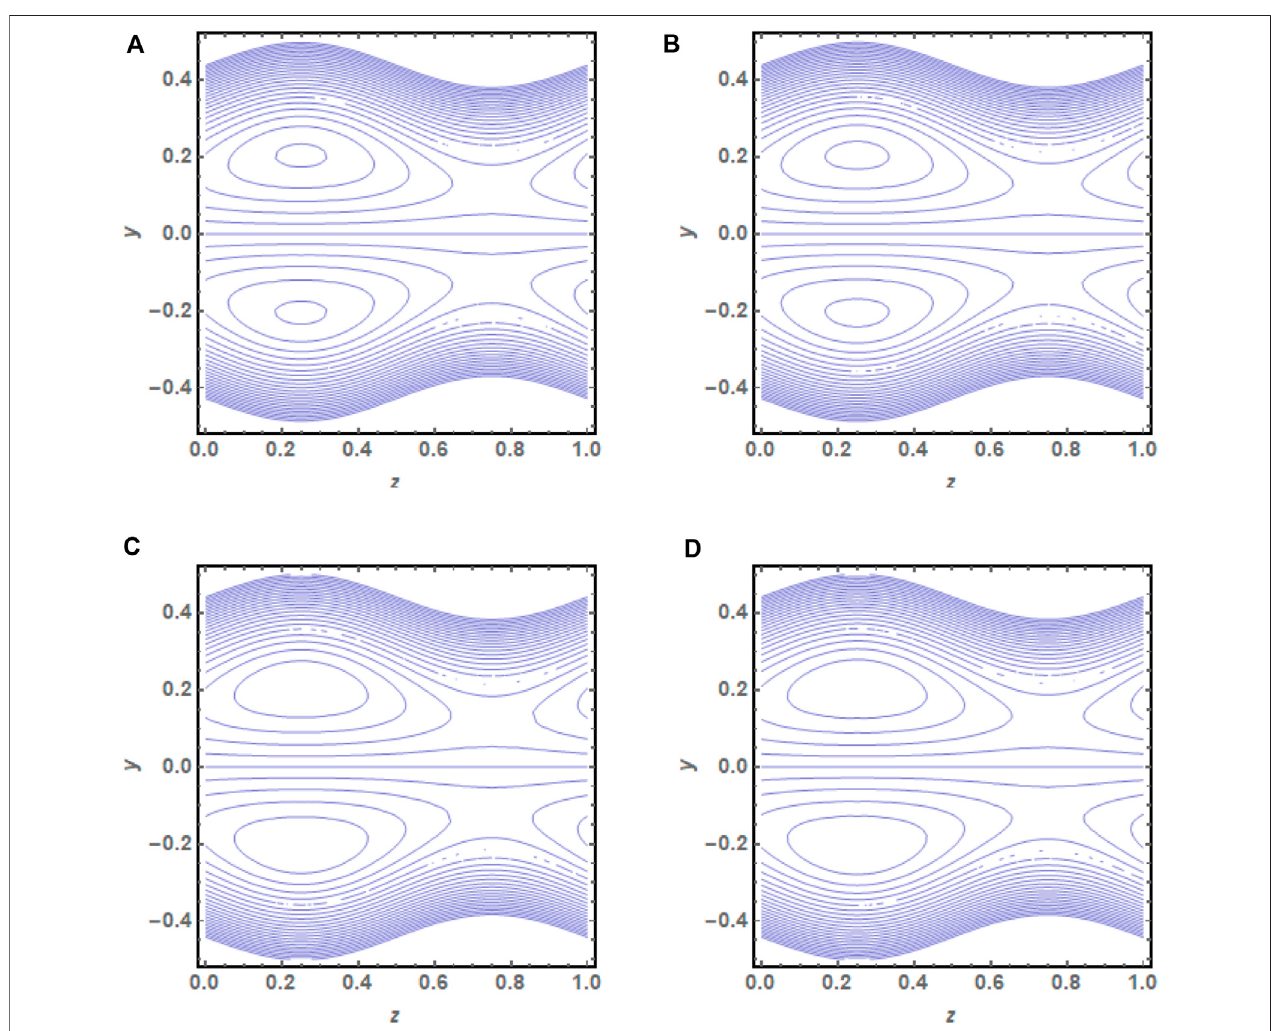
FIGURE 13 | (A) Streamlines plot at fl ow rate (cid:1) 0 . 01. (B) Streamlines plot at fl ow rate (cid:1) 0 . 03. (C) Streamlines plot at fl ow rate (cid:1) 0 . 05. (D) Streamlines plot at fl ow rate (cid:1) 0 . 07.